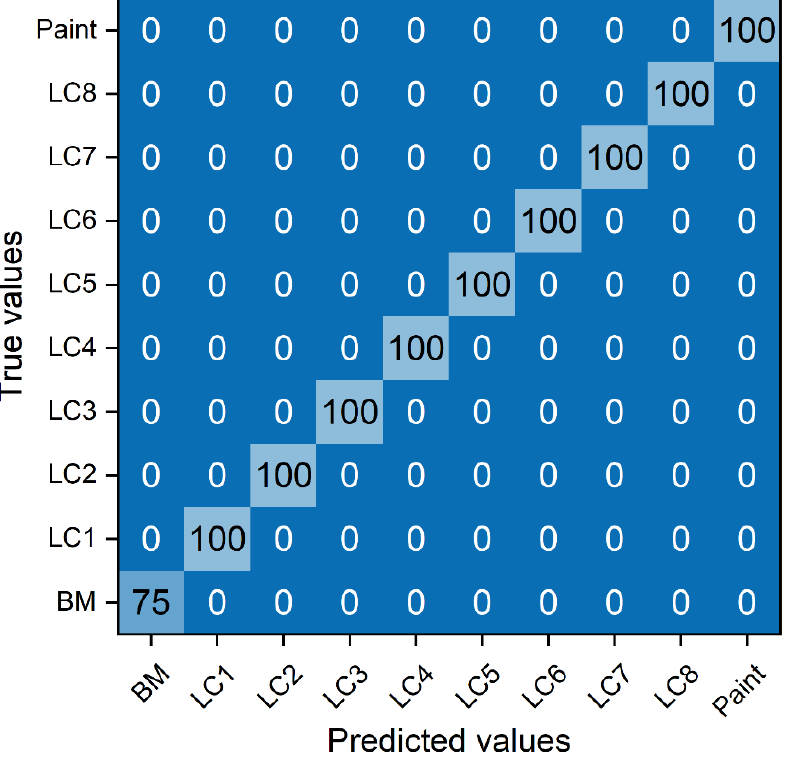
Figure 8. Confusion matrix after 20 epochs.